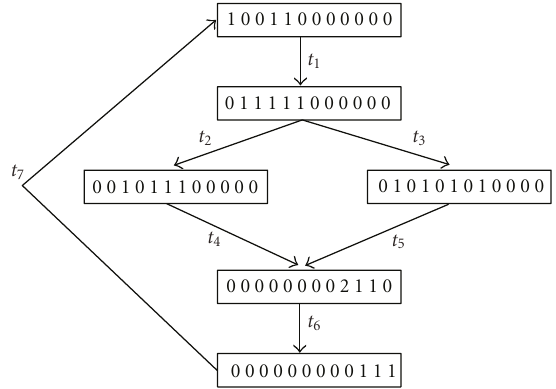
Figure 7: Coverability graph for some states and transitions of Figure 6.